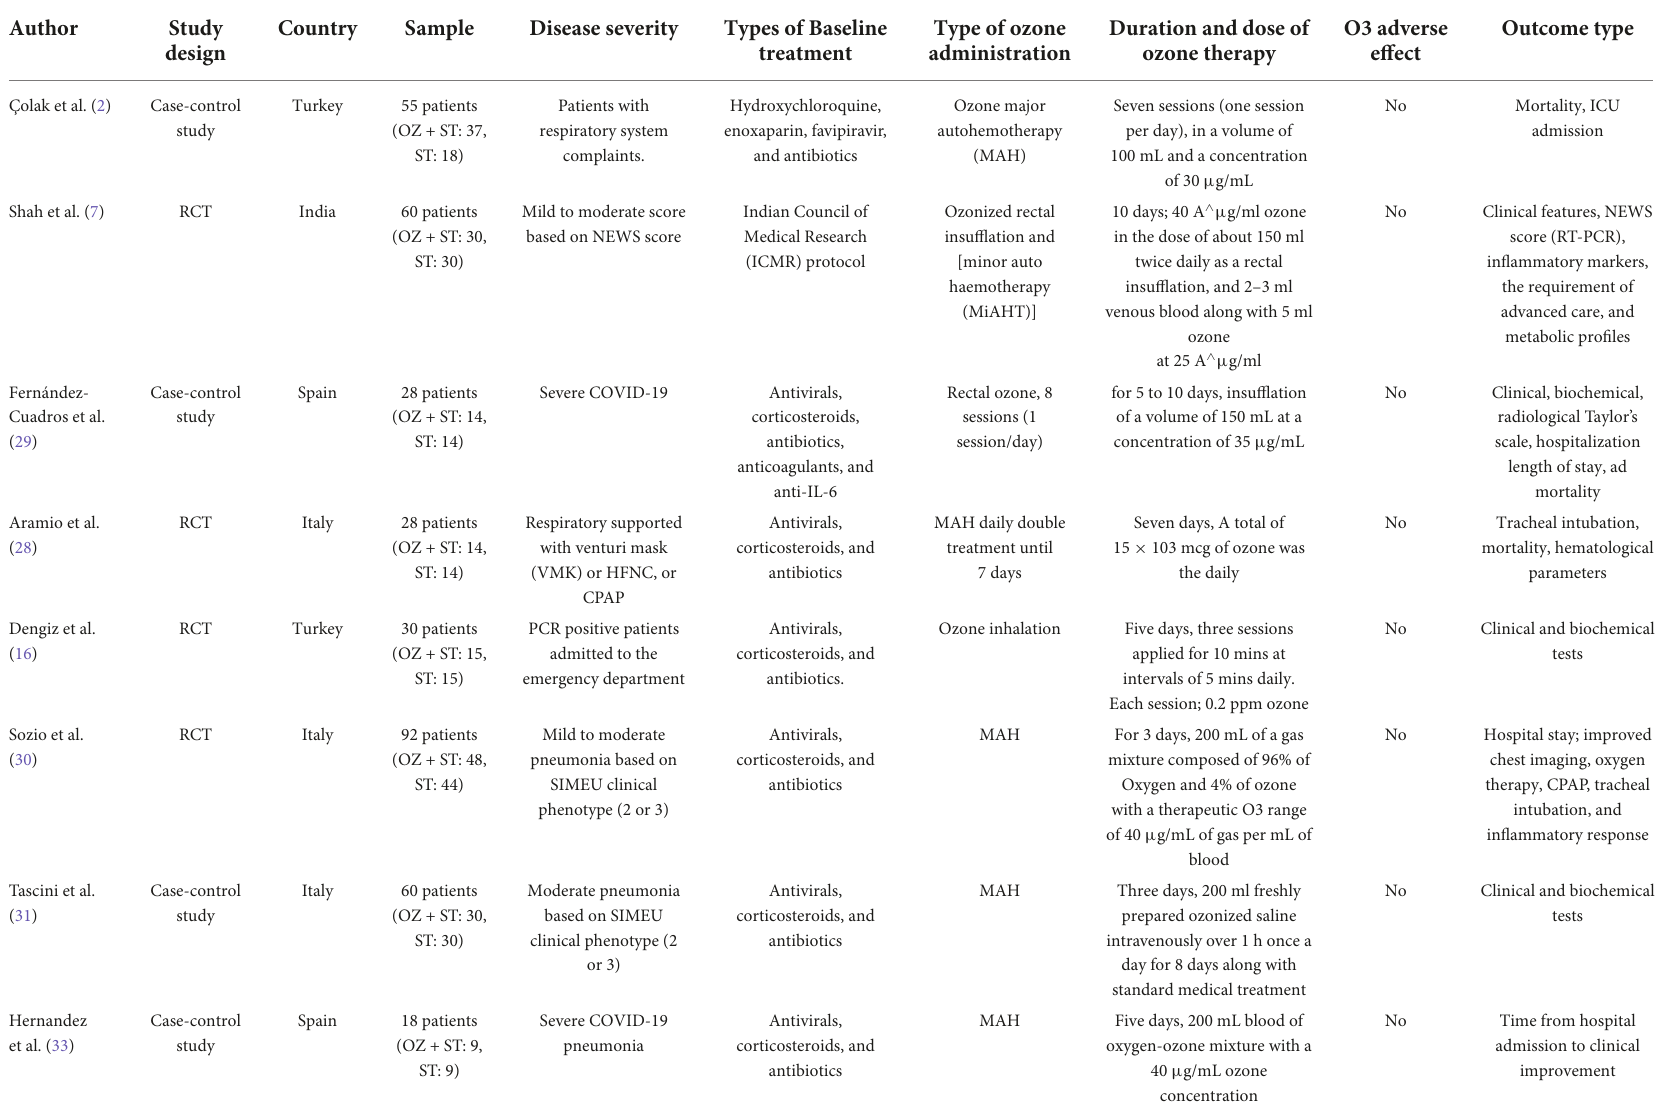
TABLE 1 Basic characteristics of included